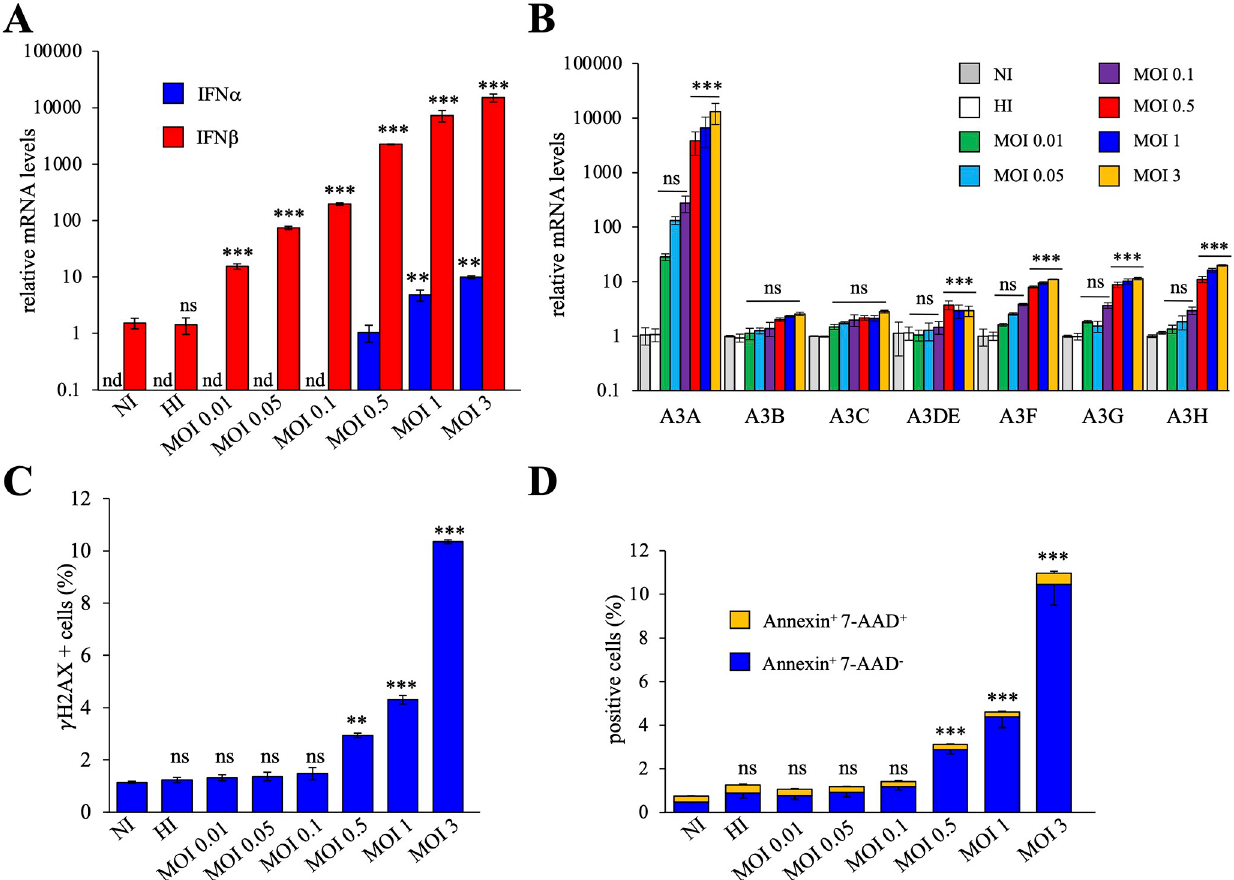
Fig 1. MeV induced APOBEC3A upregulation. A) Relative expression of IFN- α and IFN- β following MeV infections at different MOIs at 24 hpi. Gene expression was normalized using the expression level of the housekeeping gene RPL13A . NI: non-infected cells, HI: cells infected with heat inactivated virus. B) A3 relative expression upon MeV infection in THP-1 cells for 24 hpi at different MOIs. A-B), mean values and standard deviations of the mean (s. e.m.) were calculated for three independent infections in duplicate (n = 6), unpaired two-side Student’s t-test, �� , p < 0.05 and ��� , p < 0.005, ns: not statistically significant, nd: not determined. C) Flow cytometry analysis of the γ -H2AX positive cells at 18 hpi by MeV at different MOIs. D) Flow cytometry analysis of the Annexin V positive cells at 18 hpi by MeV at different MOIs. C-D), mean values and s.e.m. were calculated for three independent infections (n = 3), unpaired two-side Student’s t-test, �� , p < 0.05 and ��� , p < 0.005, ns: not statistically